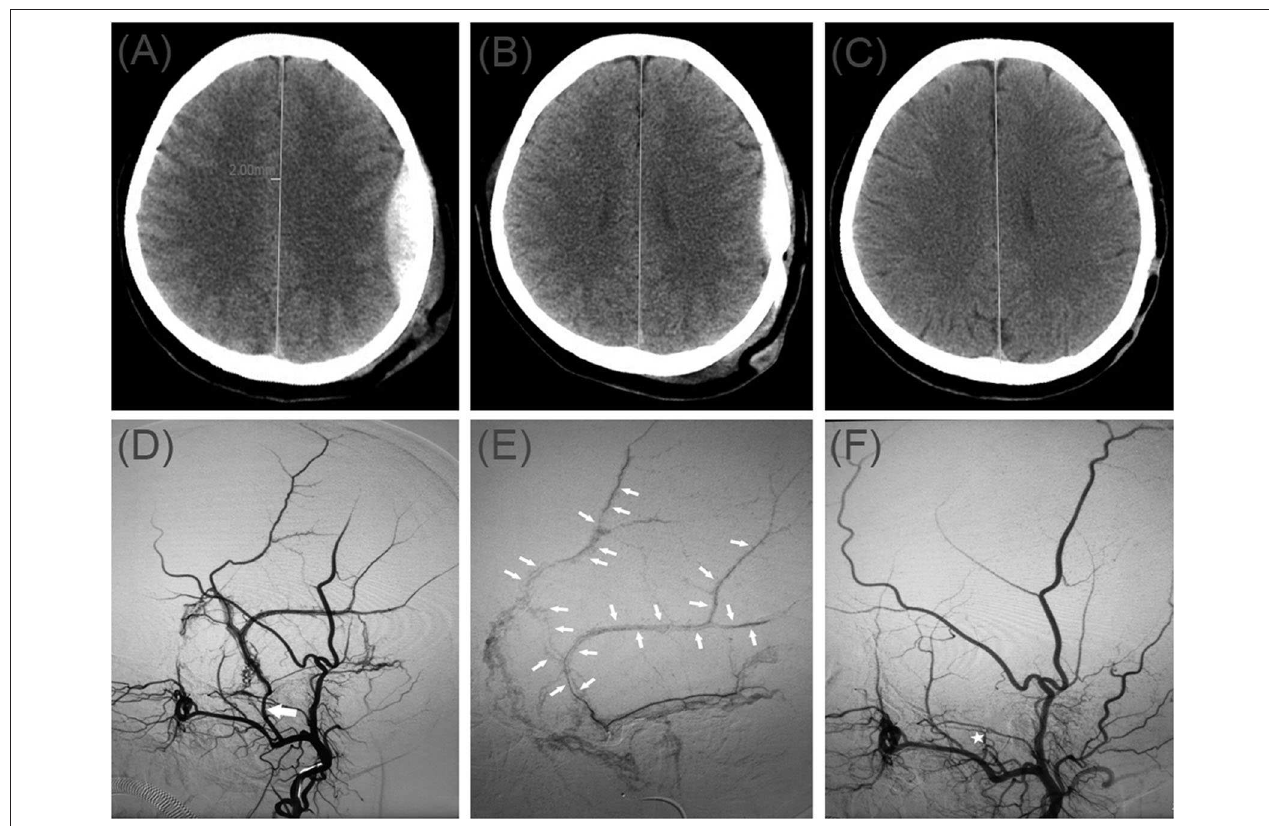
FIGURE 1 | (A) Brain computed tomographic hematoma images for patient 1 before treatment (midline shift: 2.00mm). (B) Brain CT was repeated on postoperative day 11. (C) Follow-up brain CT was performed at 88 days. (D) Pre-operative DSA presented abnormal MMA (Large arrow). (E) Intra-operative DSA showed contrast agent extravasation or arteriovenous fistula (Small arrow). (F) Postoperative DSA found that the MMA disappeared (Asterisk). DSA, digital subtraction